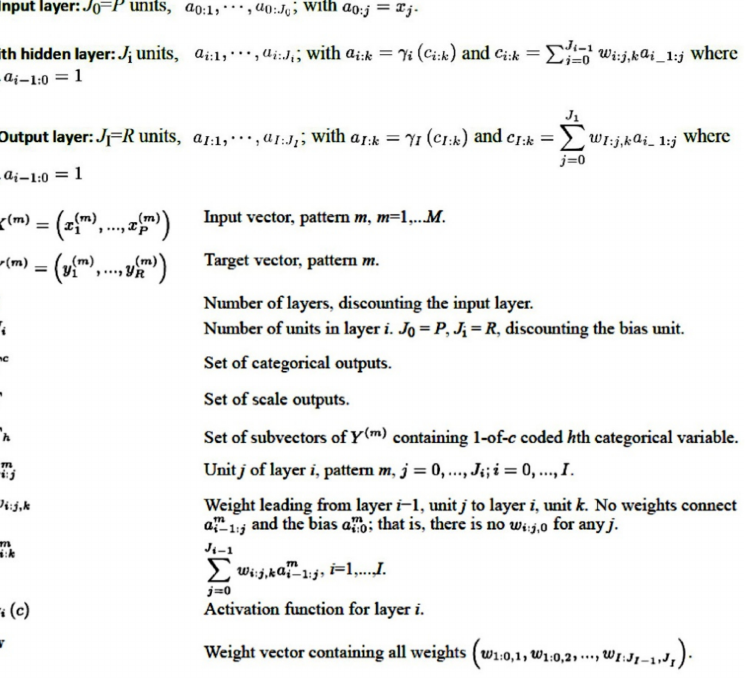
Figure 3. Architecture of the multilayer perceptron (MLP). The MLP is an artificial neural network that is characterized by a feedforward structure and supervised learning. The MLP network is a function of one or more predictors (known as inputs or independent variables) that minimizes the prediction error on one or more target variables (outputs). This figure shows the general architecture for the MLP network and the corresponding